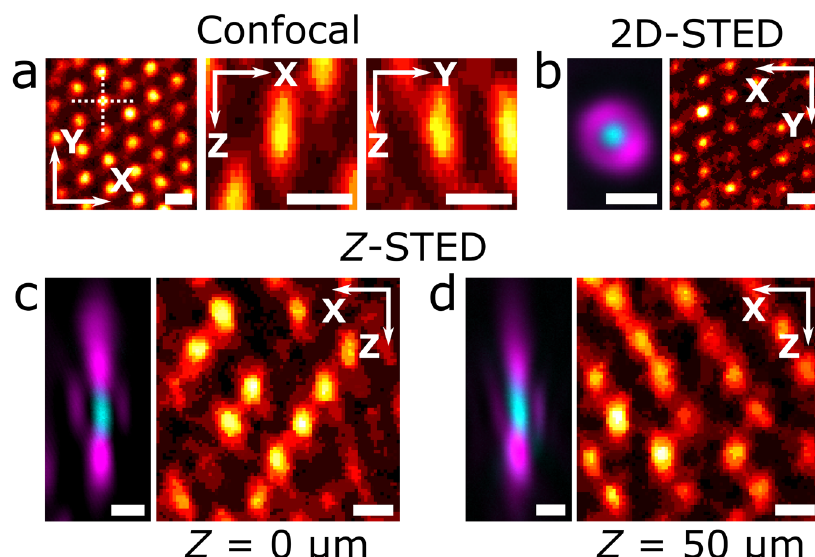
Fig. 3 Alignment of confocal STED microscope. a Slices from a confocal Z -stack of fl uorescent cores in a colloidal crystal close to the cover glass, recorded with a Leica HC PL APO 100×/1.40 OIL STED WHITE objective (2 pixel 3D median fi lter), showing the response function of the microscope in the lateral plane (left), XZ plane (middle) and YZ plane (right). The two axial planes are marked by the dashed lines in the lateral plane (left). Alignment of 2D-STED ( b ) and Z -STED ( c , d ) excitation (cyan) and depletion (magenta) lasers in the lateral plane, as imaged using a Leica HC PL APO 93×/1.30 GLYC motCORR STED WHITE objective in re fl ection mode (left) using a gold core particle close to ( b , c ) and 50 μ m ( d ) from the cover glass, and the resulting STED images (2 pixel median fi lter) of the fl uorescent cores in the crystal (right), showing increased resolvability of the particles in the crystal as compared to ( a ). Pinhole size in fl uorescence images: ( a ) 0.7 and ( b – d ) 1 Airy unit, in all re fl ection mode images: 4.7 Airy units. All scale bars are 500 nm. Color tables used correspond to those plotted in Fig.